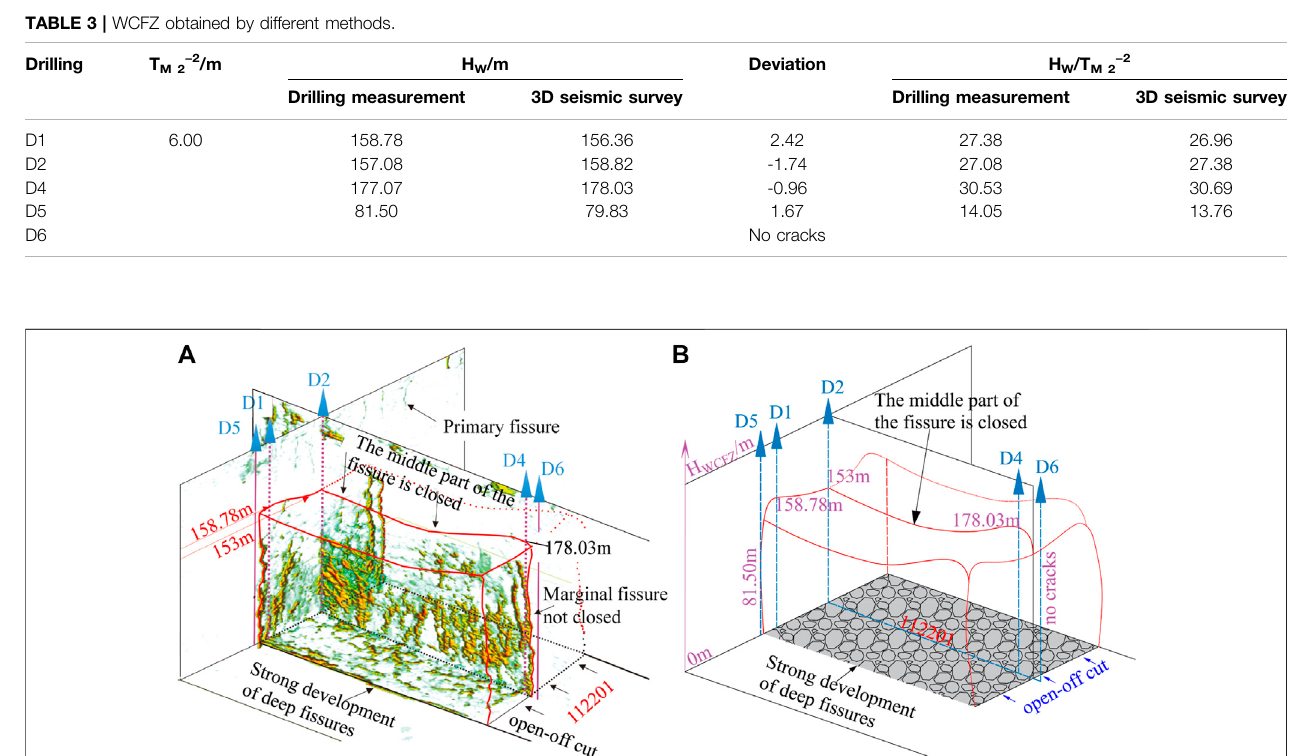
Frontiers in Earth Science |